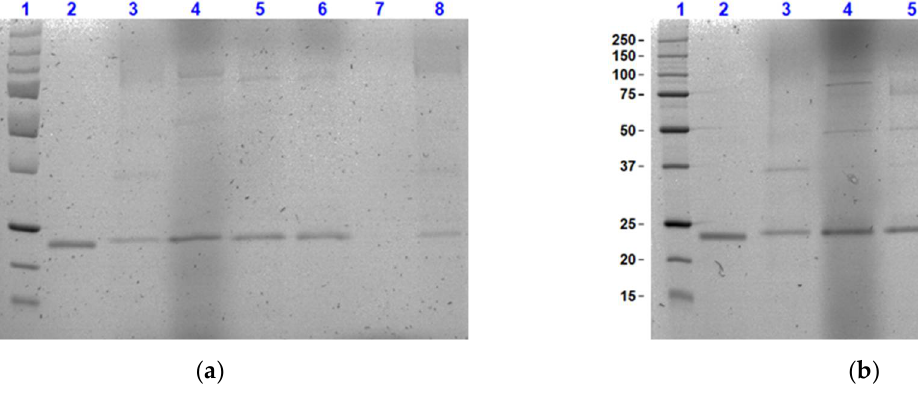
Figure 3. SDS PAGE analysis performed for detection of thaumatin at pH ( a ) 5.0 and ( b ) 6.0 when grown at 30 °C. Lane 1: Bio-Rad precision plus unstained (kDa); Lane 2: Thaumatin standard 37.5 mg/L; Lane 3: MGY medium; Lane 4: BMGY medium; Lane 5: BSM; Lane 6: FM22 medium; Lane 7: MBSM; Lane 8: d’Anjou medium.